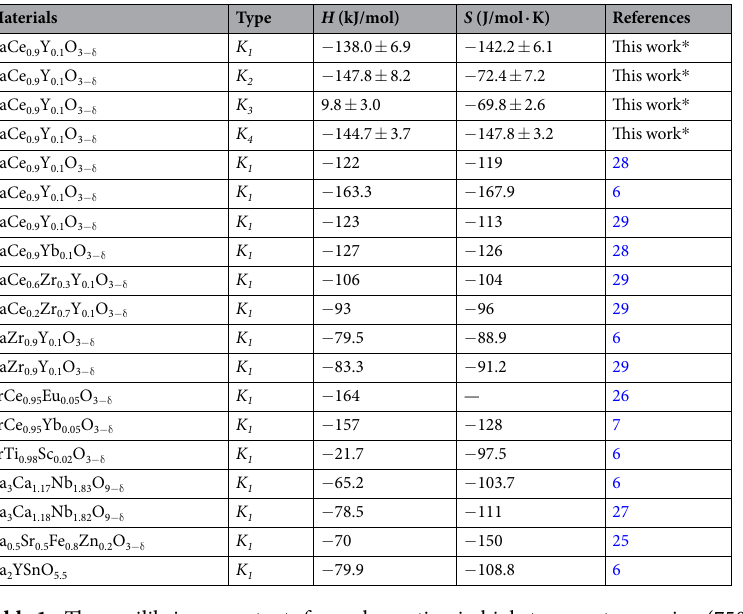
Table 1. The equilibrium constants for each reaction in high-temperature region (750–1000 °C). * The value of “This work” is calculated with temperature range of 1000–750